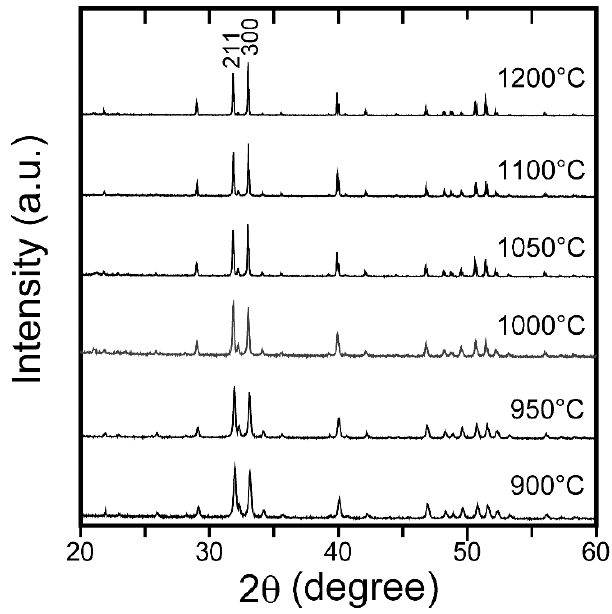
Figure 5. XRD pattern of FAP ceramics sintered at various SPS temperatures.